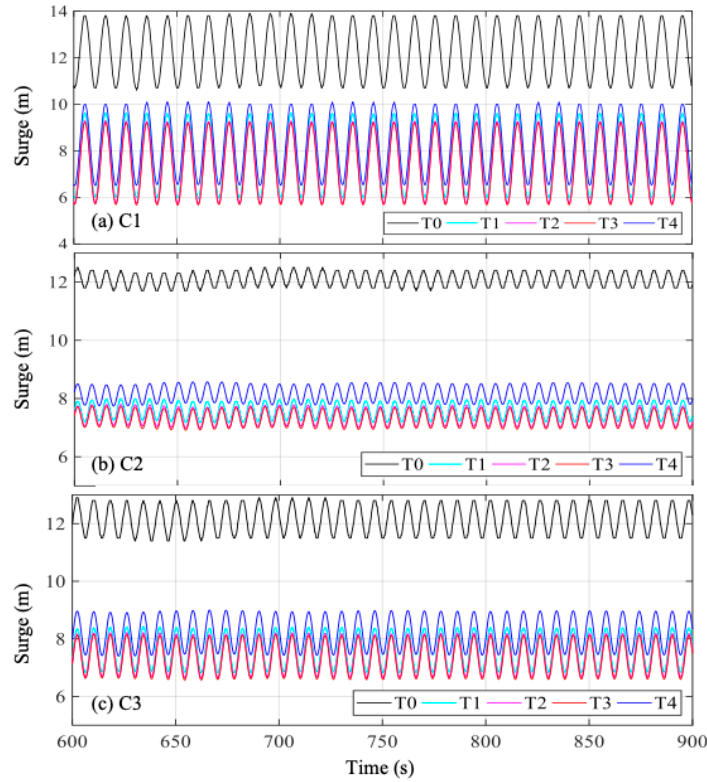
Figure 7. Wind turbine surge movement time series in ( a ) C1, ( b ) C2, and ( c )